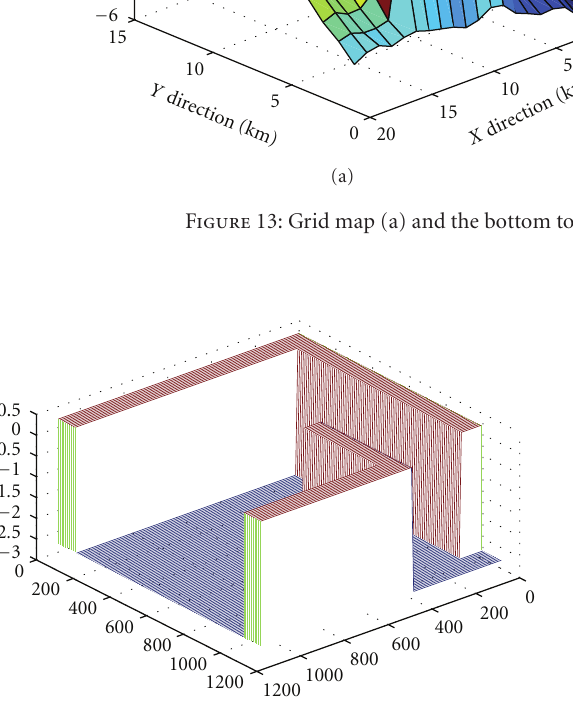
Figure 14: Geometry of the idealized breakwater.